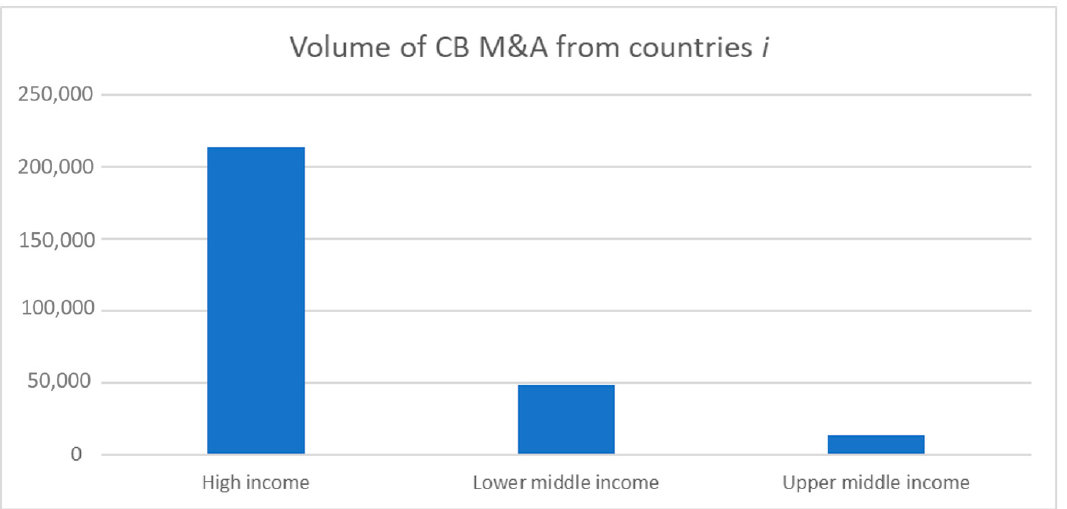
Figure 1. Sum of CBM&A volume from countries i, classified based on income groups. (Source: Author’s consolidation based on World Bank’s country classification).